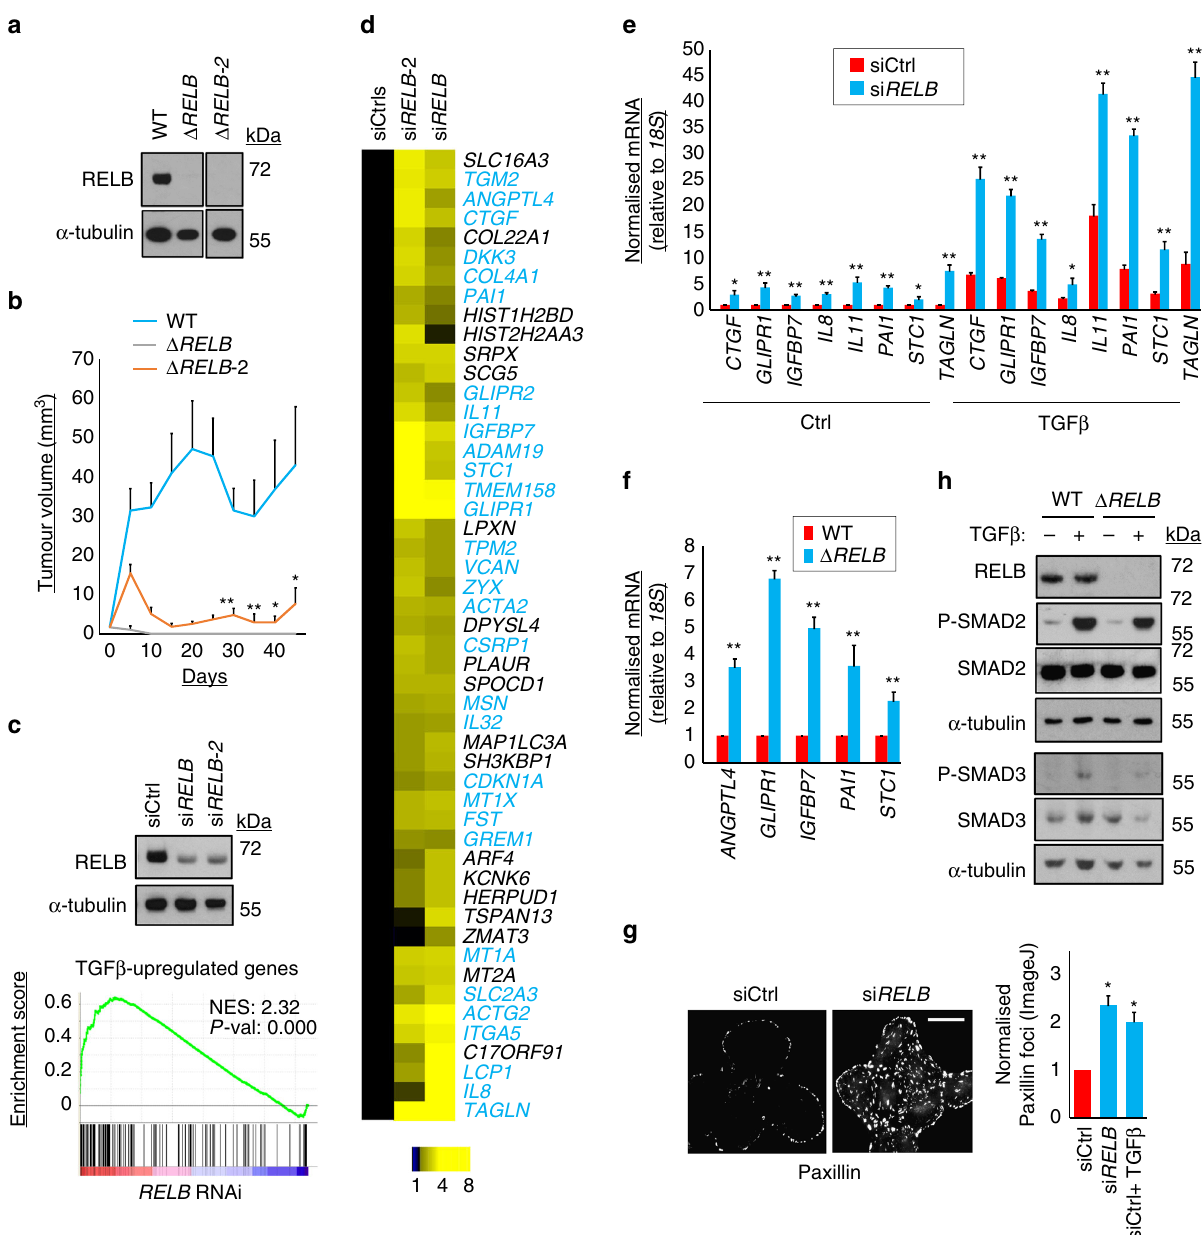
Fig. 5 RELB promotes tumorigenesis and suppresses TGF β target gene expression. a A549 Δ RELB cell clones ( Δ RELB and Δ RELB -2) generated using CRISPR/Cas9 and two independent gRNA sequences were immunoblotted as shown. b A549 WT, Δ RELB and Δ RELB-2 cells were subcutaneously injected into immunocompromised mice and tumour volume was measured longitudinally (means, n = 12 fl anks, ± S.E.M., * P < 0.05 or * P < 0.01 vs. WT, two-tailed t -test). c Two sequence-unrelated siRNA oligonucleotides targeting RELB were transfected in A549 cells (knockdown con fi rmed by immunoblotting). Expression pro fi ling was performed vs. two sequence-unrelated non-targeting controls (Supplementary Data set 1). GSEA was performed, comparing genes differentially expressed in RELB knockdown cells with known oncogene and tumour suppressor pro fi les. The comparison yielding the greatest normalised enrichment score (NES), ‘ TGF β upregulated genes ’ , is shown here. d Fold-change heat map showing top 50 upregulated genes after RELB RNAi. Individual mean RELB siRNA values are normalised to the averaged means of the controls (siCtrls). Blue text indicates genes known to be transcriptionally upregulated downstream of TGF β (Supplementary Table 2). e , f qRT-PCR was performed for the indicated transcripts after the following treatment regimens in A549 cells. e A549 cells were transfected with siCtrl or si RELB for 72 h. Cells were either left untreated (Ctrl) or treated with 5 ng/ml TGF β 1 for the fi nal 16 h of transfection. f Exponentially dividing A549 WT and Δ RELB cells were compared. (means, n = 3, ± S.D., * P < 0.05 or ** P < 0.01 vs. similarly treated siCtrl or WT cells, two-tailed t -test). g A549 cells were transfected with the indicated siRNA for 72 h, stained for paxillin and then imaged by wide fi eld microscopy ( scale bar = 20 µ m). As a positive control, siCtrl cells were treated with 5 ng/ml TGF β 1 for 8 h prior to fi xation (+TGF β ). Paxillin foci were quanti fi ed on a per cell basis by image analysis (means, n = 3, ± S.E.M., * P < 0.05, two-tailed t -tests vs. siCtrl). h A549 WT or Δ RELB cells, with (+) or without ( − ) prior treatment with 5 ng/ml TGF β 1 for 16 h, were immunoblotted as shown (P-SMAD2 = phospho-S465/467 SMAD2, P-SMAD3 = phospho-S423/425 SMAD3). Uncropped blots are available in Supplementary Fig.